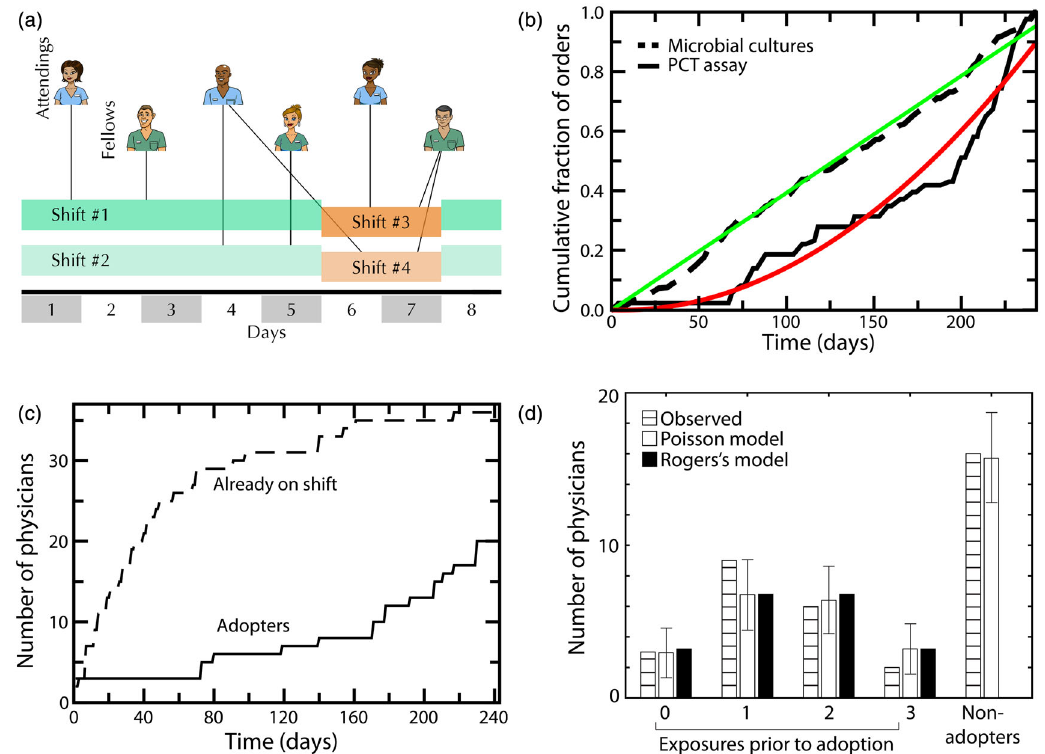
FIG. 1. Experimental conditions of innovation adoption in the medical ICU at Northwestern Memorial Hospital. (a) Schematic of attending and fellow physician schedules. On weekdays (shifts 1 and 2), each of two ICU teams include one attending physician (blue), one fellow (green), and several residents (not pictured). On weekends (shifts 3 and 4), each team has one attending physician, but a single fellow is assigned to both. A third team is established on 1/1/2012 (not pictured). (b) Cumulative fraction of microbial cultures (dashed black line) and PCT assays (solid black line) ordered during the experiment. Cumulative microbial culture orders increase linearly ( y ¼ 0 . 004 x , correlation coefficient ¼ 0 . 997 , solid green line), as expected for the gold standard for diagnosing bacterial infection. A quadratic increase in cumulative PCT orders ( y ¼ − 2 × 10 − 4 þ 1 . 6 × 10 − 5 x 2 , correlation coefficient ¼ 0 . 979 , solid red line) supports the hypothesis that adoption of the PCT assay increases over time. (c) Rate of adoption of the PCT assay among the physicians in the study. Two physicians are adopters prior to the start of the experiment. Adoption of the PCT assay increases over time (solid line) but is slower than the increase in the number of distinct physicians who have already been on shift (dashed line). The data suggest that adoption requires exposure over multiple shifts before adoption occurs. (d) Distribution of adopters according to number of exposures by a unique physician prior to adoption. An exposure is defined as being on shift with a unique adopter. The empirical distribution (striped bars) is compared with the expected distribution if the data were generated by a Poisson process (white bars) and with the expected distribution according to Rogers ’ s categorization of adopters (black bars). In Rogers ’ s categorization, we classify innovators and early adopters, early majority, late majority, and laggards as physicians who adopted after zero, one, two, and three prior exposures, respectively. (Rogers ’ s framework does not consider